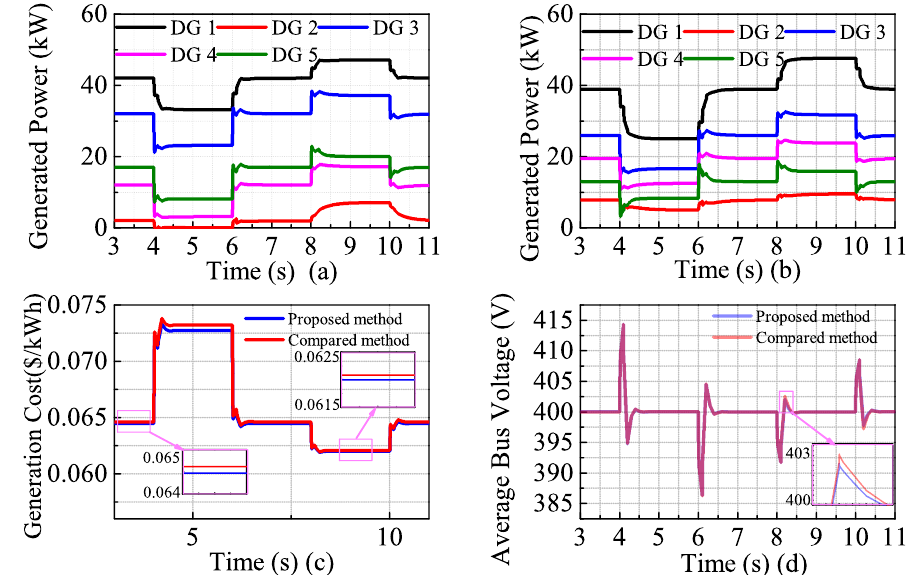
Figure 12. Comparative studies between the proposed control strategy and distributed cooperative control. ( a ) Generated power of each DG with the proposed control strategy. ( b ) Generated power of each DG with the conventional distributed cooperative control. ( c ) Total generation cost of all the DGs. ( d ) Average bus voltage of the